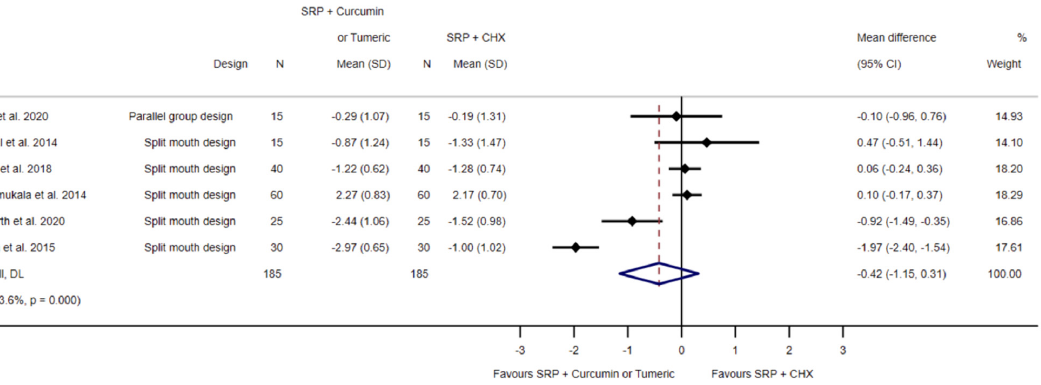
Figure 4. Forest plot for the comparison of SRP and chlorhexidine to SRP and local curcumin/turmeric related to clinical attachment level loss